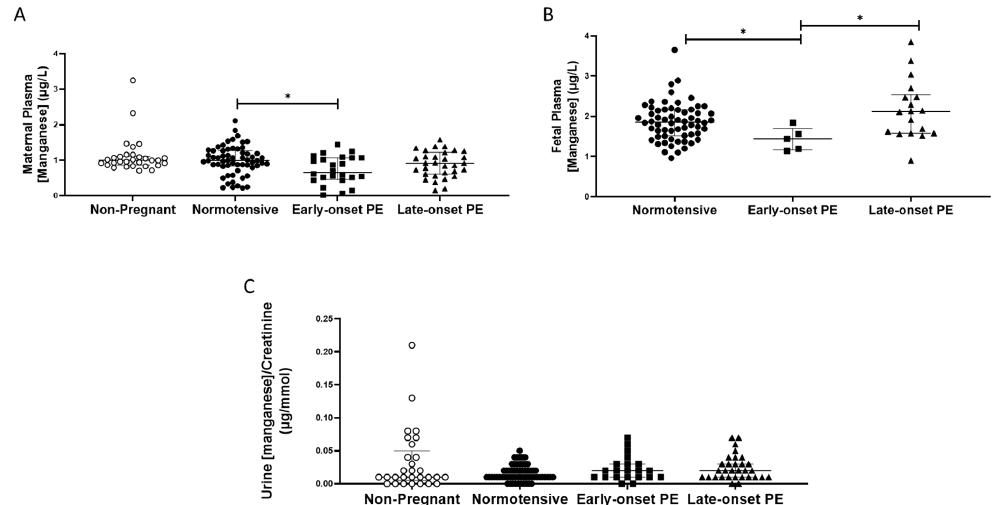
Figure 3. ( A ) Maternal plasma manganese concentrations in non-pregnant (n = 30), normotensive pregnant women (n = 60) and those with early- (n = 24) and late-onset (n = 31) pre-eclampsia (PE); ( B ) umbilical cord venous (fetal) plasma manganese concentrations in normotensive pregnant women (n = 60) and those with early- (n = 5) and late-onset (n = 18) PE; ( C ) Urinary manganese/creatinine concentrations in non-pregnant (n = 28), normotensive pregnant women (n = 60) and those with early- (n = 23) and late-onset (n = 31) PE. Data presented as median (IQR); * p <